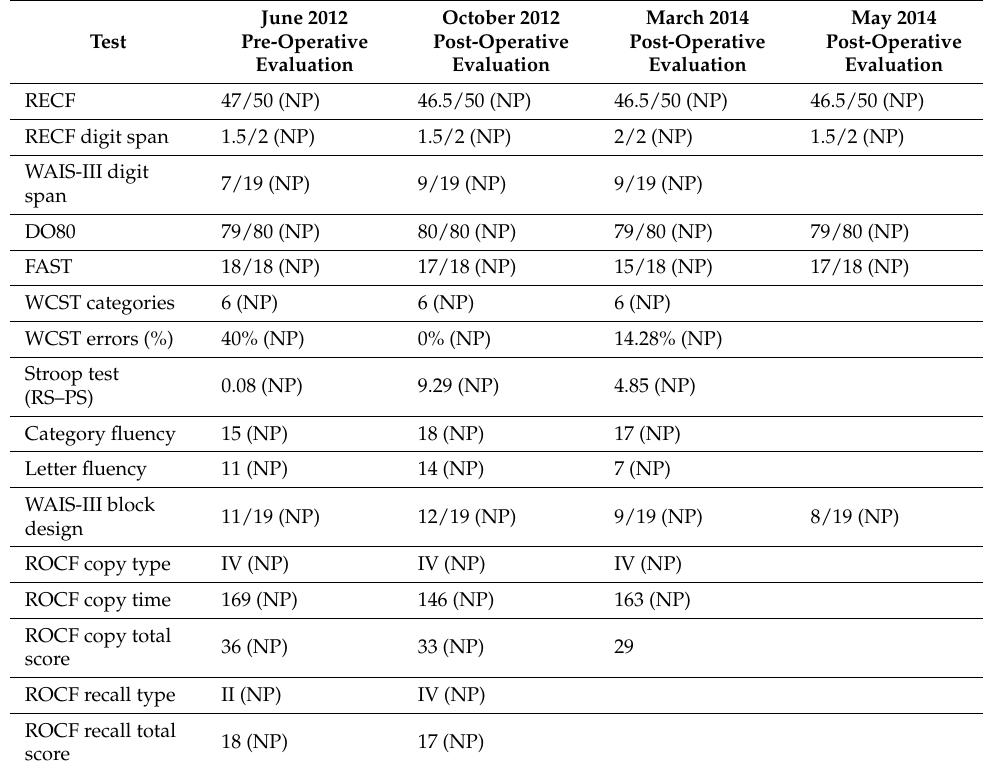
Table 1. Results of pre-operative (in June 2012) and post-operative neuropsychological assessments (in October 2012, March and May